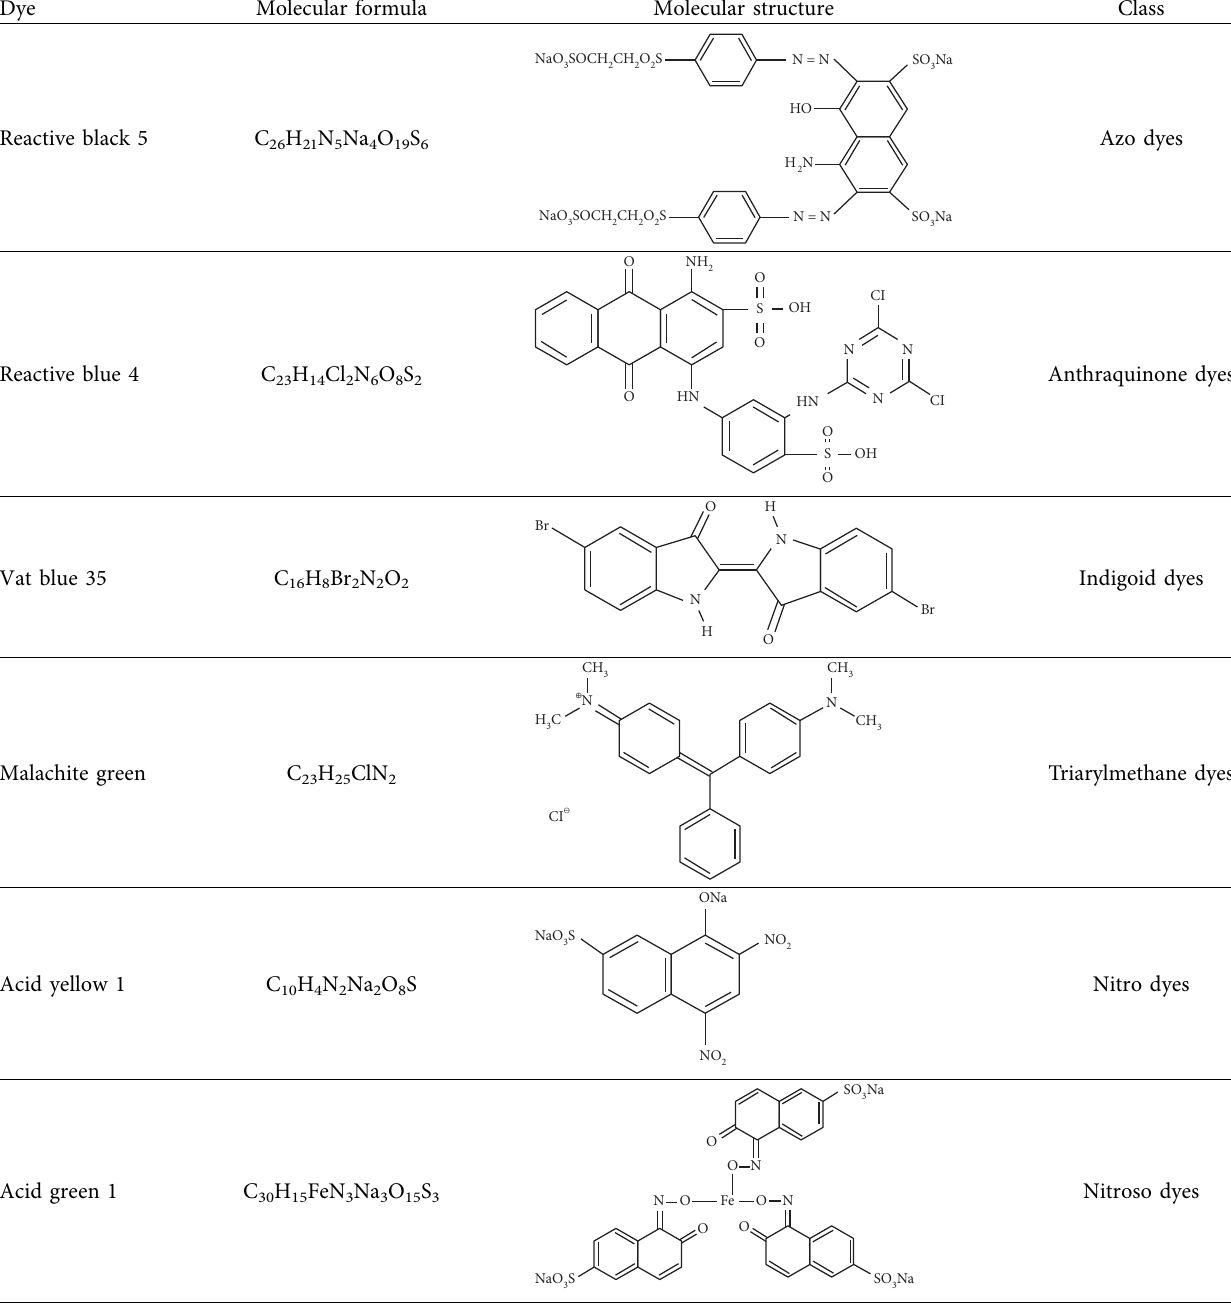
Table 1: Examples of dyes and their main chemical characteristics [5,